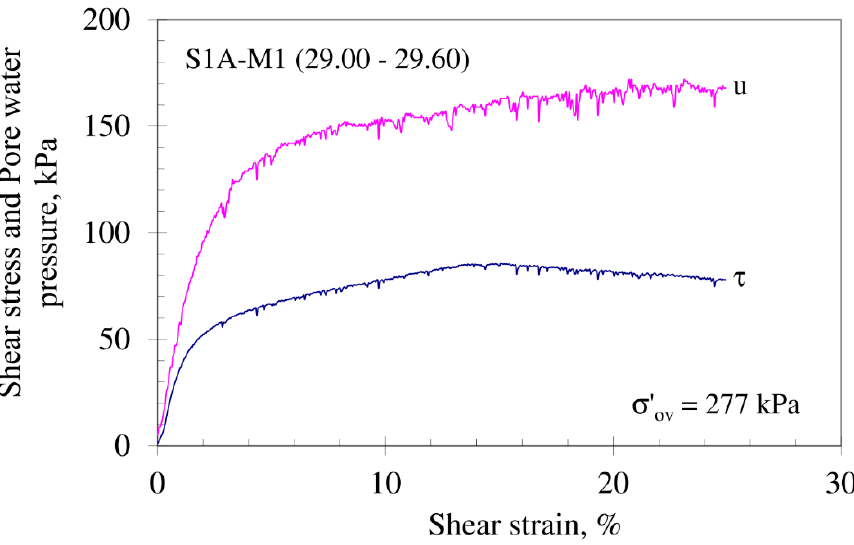
Figure 5. Variation of the shear stress ( τ ) and pore water pressure (u), as a function of the monotonic shear strain ( γ m ).